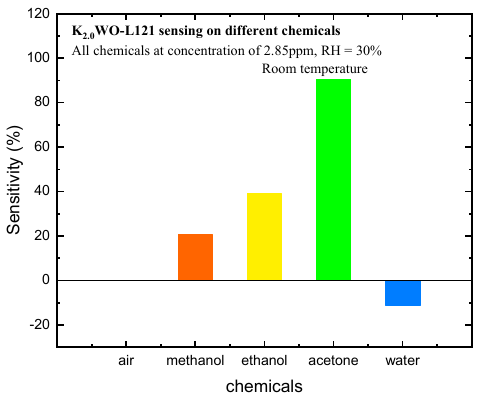
Figure 5. Selectivity testing of K 2.0 WO-L121 to 2.85 ppm of acetone, ethanol, methanol, and water vapor (the concentration of air is arbitrary).